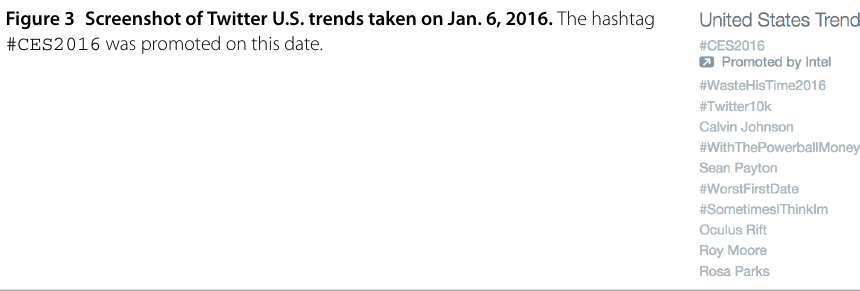
Figure 3 Screenshot of Twitter U.S. trends taken on Jan. 6, 2016. The hashtag #CES2016 was promoted on this